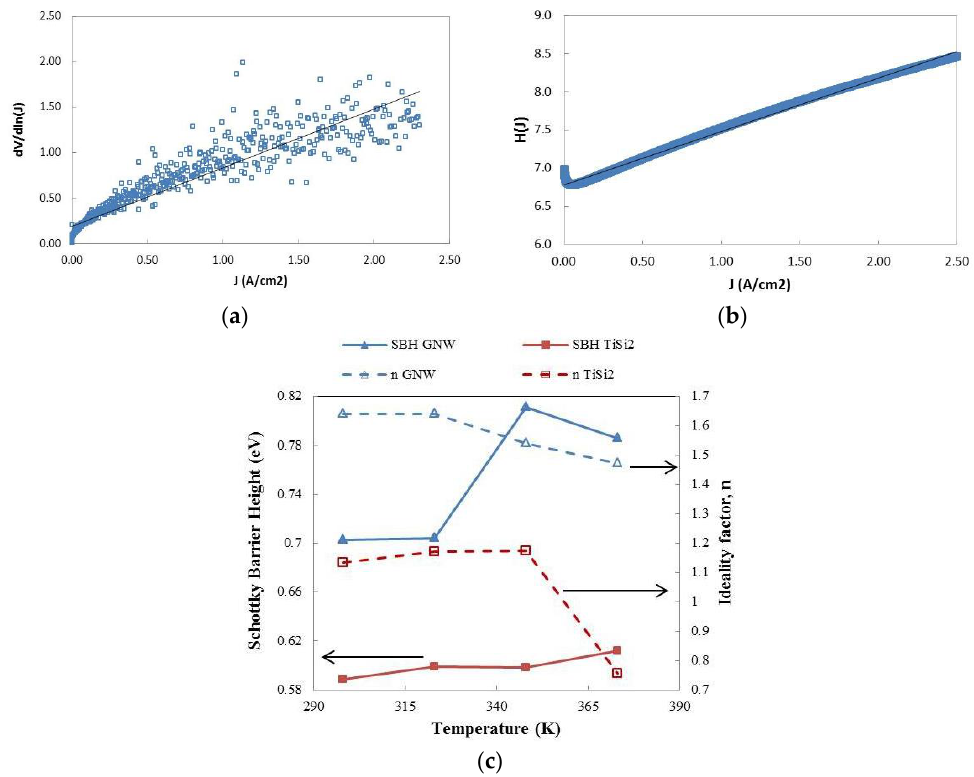
Figure 7. GNW-TMBS diode plots to extract Schottky parameters. ( a ) d V / d ln ( J ) vs. J and ( b ) H( J ) vs. J . ( c ) Temperature dependence of ideality factor and barrier height for GNW and TiSi 2 based on Cheung’s